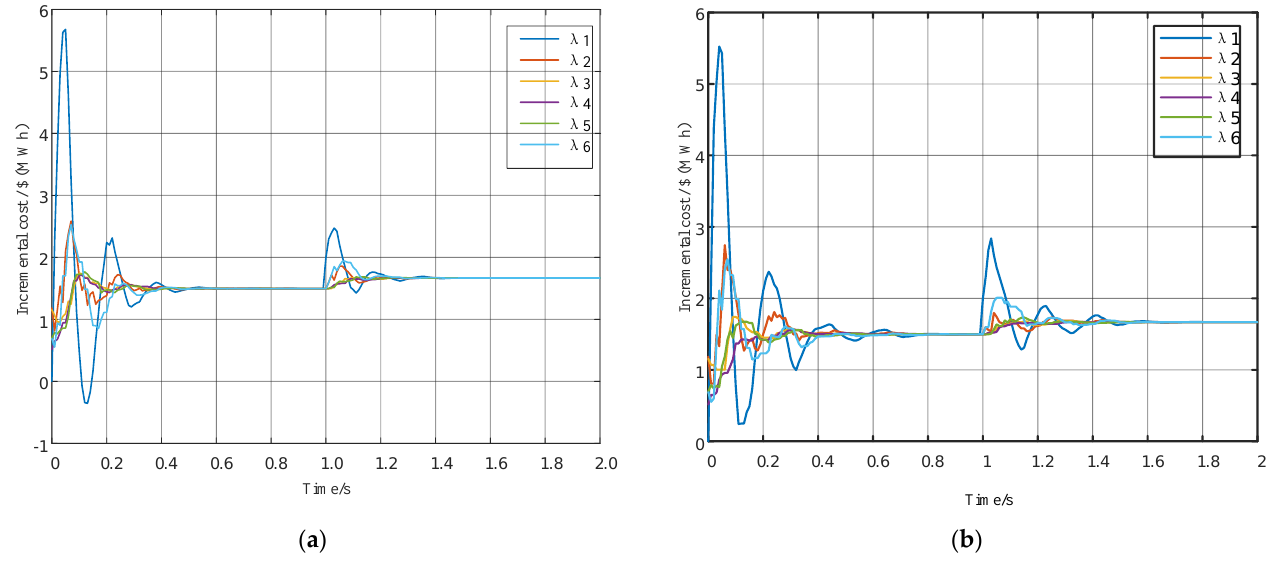
Figure 6. Incremental costs for p = 0.7 and p = 0.5: ( a ) p = 0.7; ( b ) p =